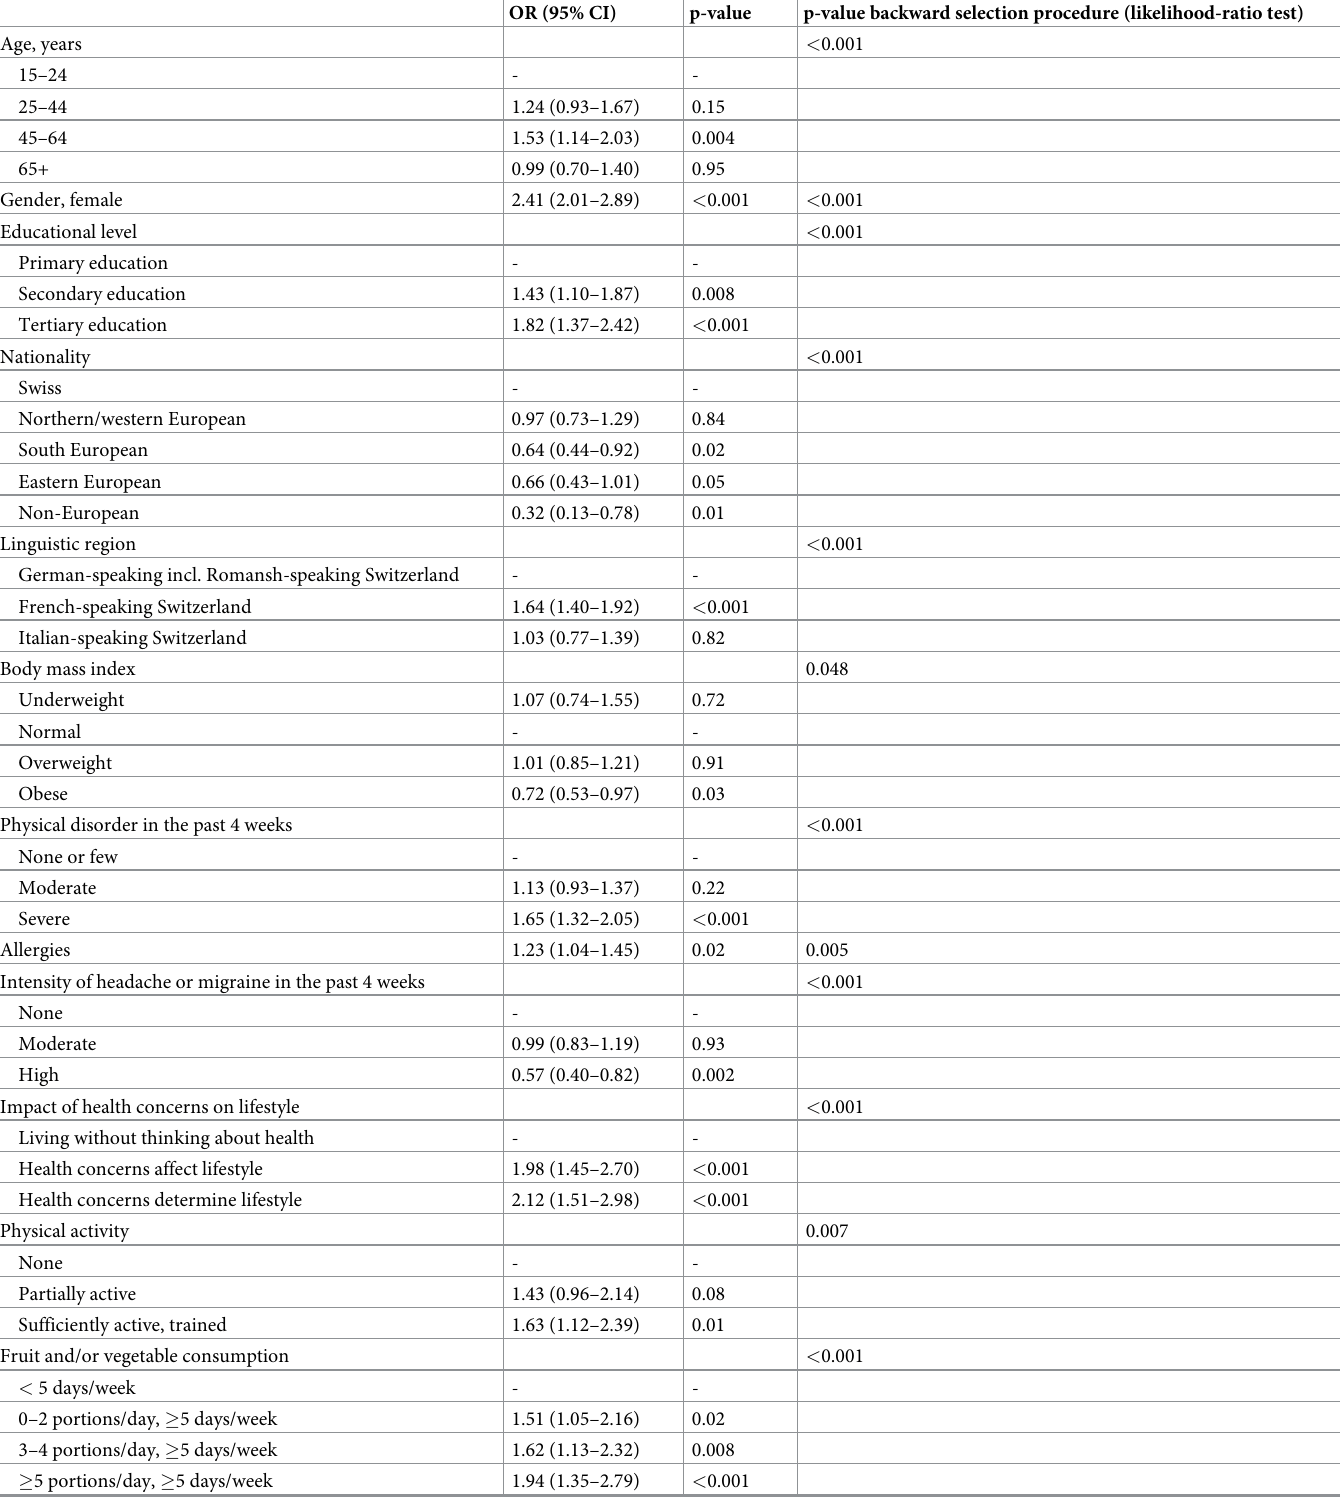
Table 6. Determinants of herbal medicine use using multivariate logistic